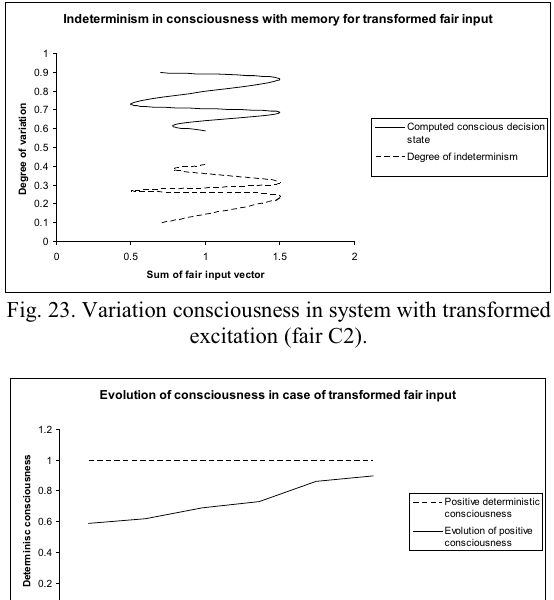
Fig. 26. Evolution of consciousness in system with transformed excitation (+biased